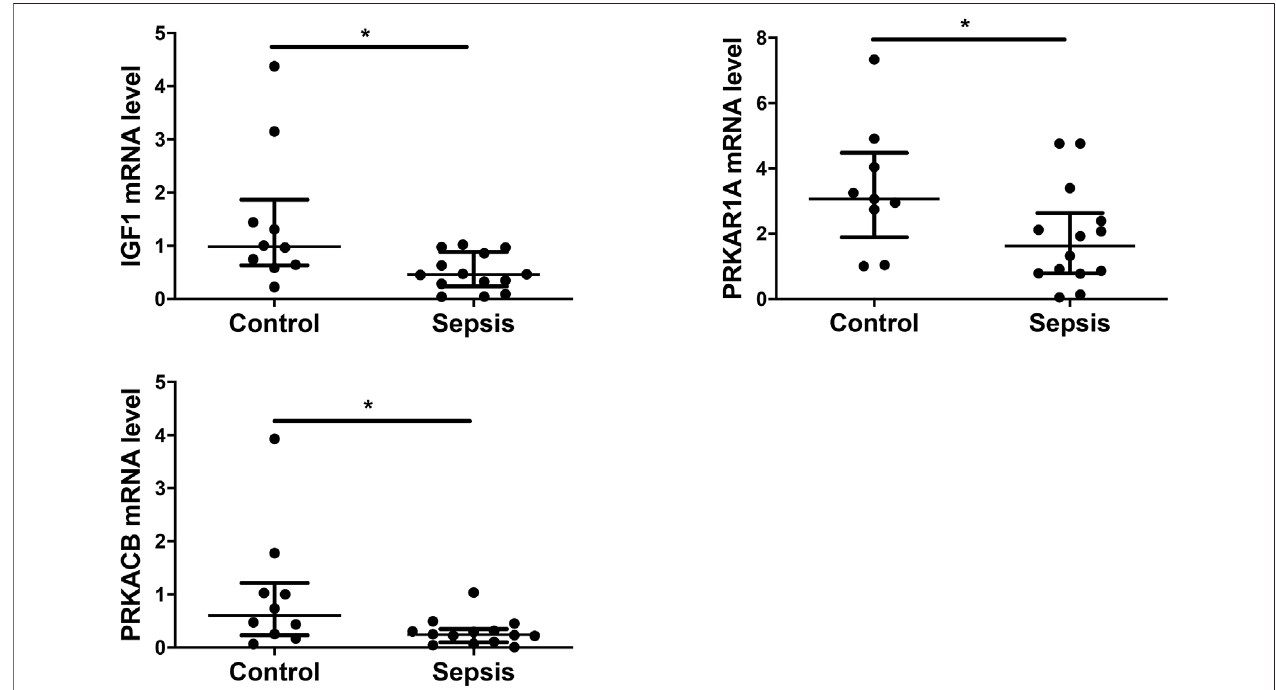
FIGURE8| Experimentalvalidationofselectedtarget genesofmiR-483-3p and let-7d-3p.Plasma EVs were analyzed for differentially expressed genesfrom aset of 8 targets via qRT-PCR. The values were relative mRNA abundance of IGF1, PRKAR1A, and PRKACB in EVs. β -actin mRNA was used as an internal control. The plot showed a median, interquartile range, and the individual data points. n = 9 – 10 for control. n = 14 for sepsis. * p < 0.05.